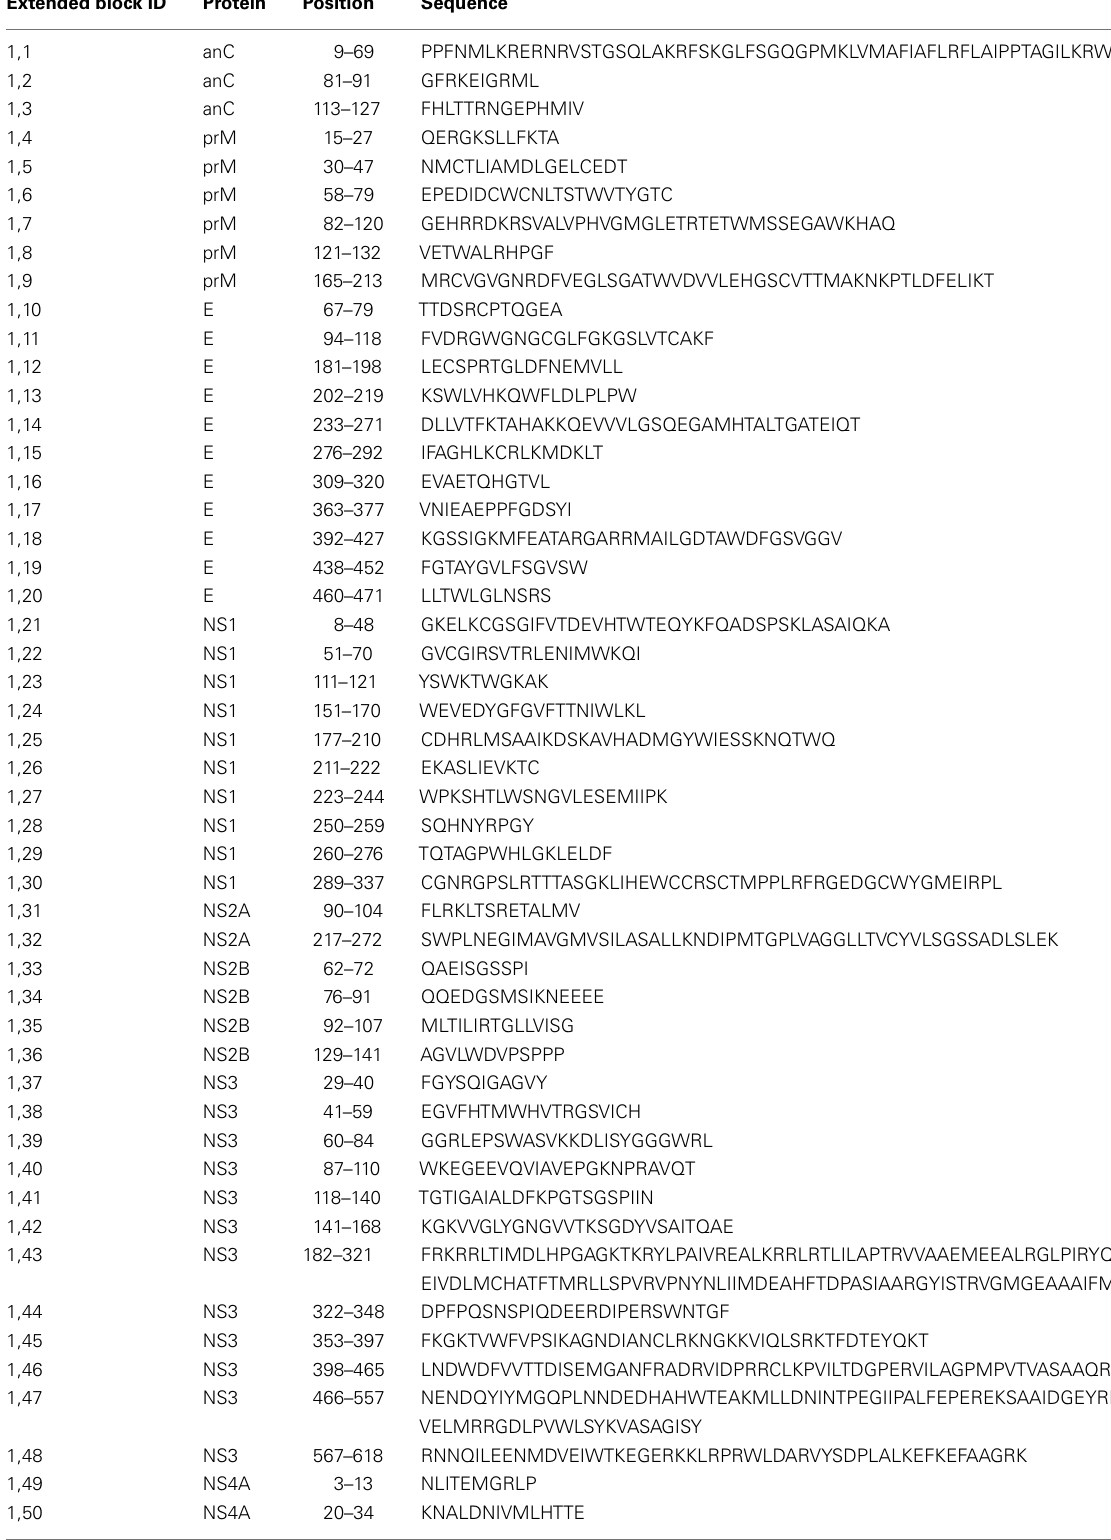
Table 6 | Extended block sequences for string